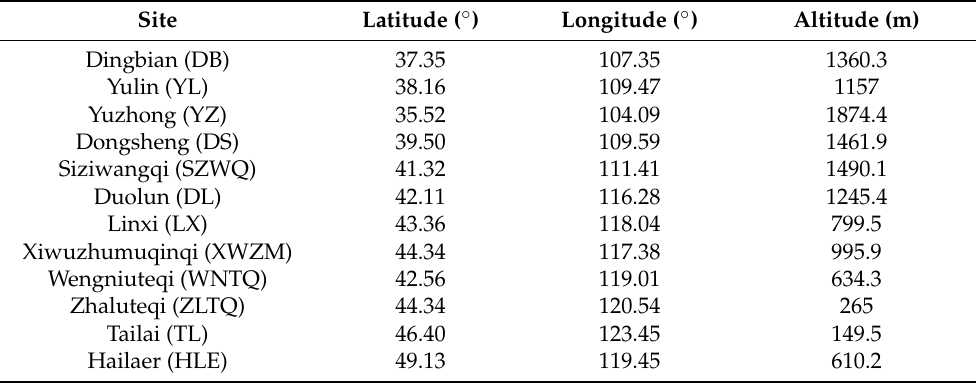
Figure 1. Distribution of experimental site and meteorological sites across the APE in North China. The full name of each meteorological site can be found in Table 1. Table 1. Study meteorological sites and experiment site.